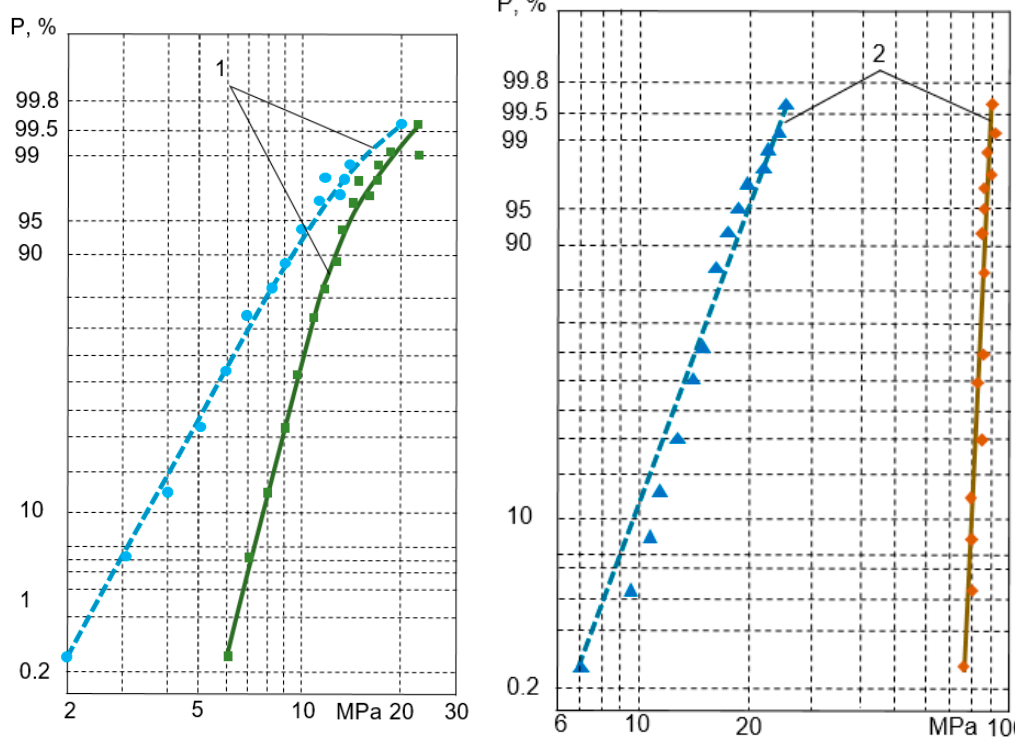
Figure 3. Statistical distribution curves for mechanical properties of steel 15Cr2MoVA: random value X (cid:48) (straight lines) and random value X ” (dashed lines); 1— σ y , 2— σ pr , 3— σ u , 4— S k .